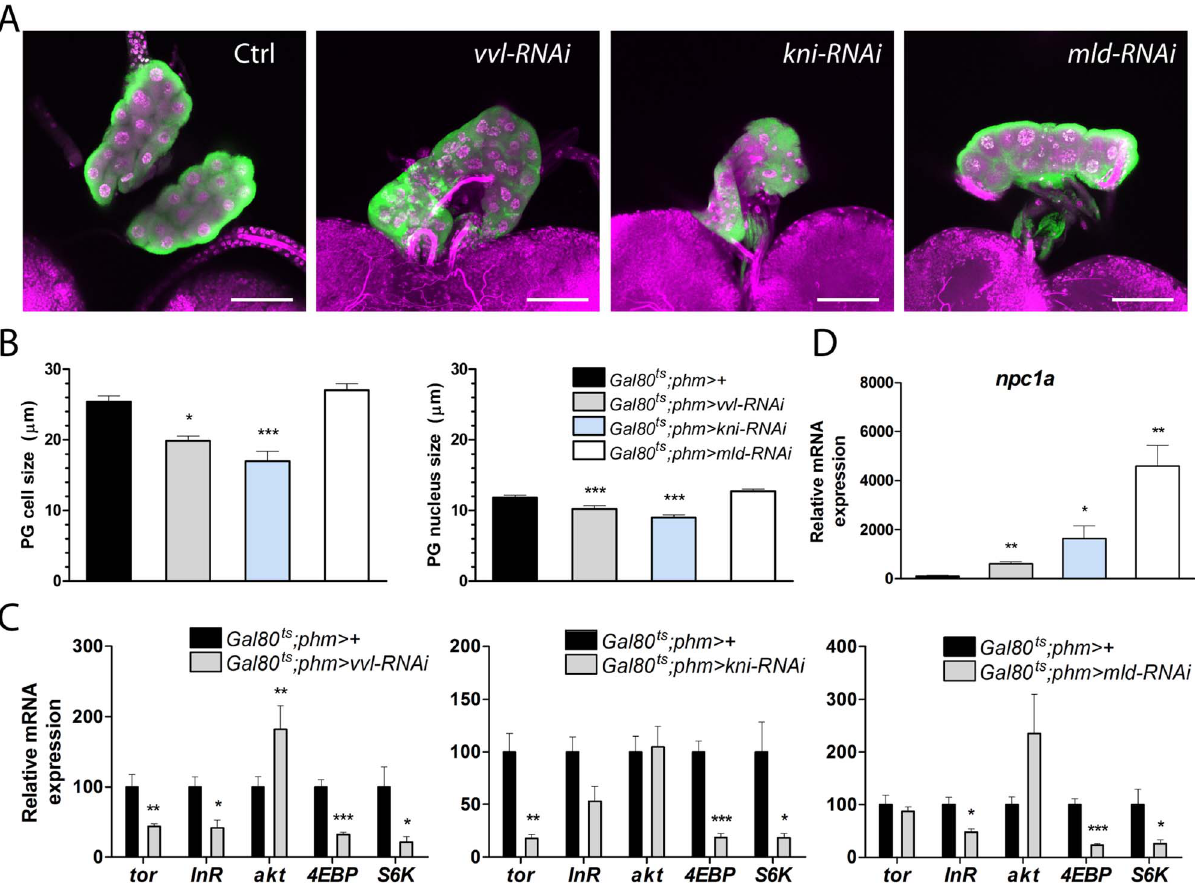
Figure 6. vvl and kni knock down affects PG cell size and disturbs PTTH/Torso and insulin/TOR signaling. (A, B) PG (green) and nuclei (magenta: DAPI) show that the morphology of the gland is intact in late L3 larvae with reduced expression of vvl , kni , or mld in the PG. PG cell and nucleus size of L3 larvae (measured as the diameter) are reduced when vvl and kni are knocked down (n=11). RNAi was induced using the Gal80 ts ; phm . 96 hours AEL corresponding to the late L2 stage at 18 u C. The PG was analyzed after two days at 29 u C when control larvae are in the wandering stage. (C) Knock down of vvl and kni results in decreased expression of torso (tor) , 4EBP and S6K in dissected ring glands containing the PG. Likewise, 4EBP and S6K are down regulated in ring glands of mld-RNAi animals that also exhibit reduced expression of the InR . Contrary, akt is increased in vvl-RNAi animals (n=4). (D) Loss of vvl , kni or mld results in a strong increase of npc1a expression in the ring gland. In C and D, expression was measured in L3 larvae raised as described in A and B (n=4). Error bars indicate s.e.m. * P , 0.05, ** P , 0.01, *** P , 0.001, versus the Gal80 ts ; phm .